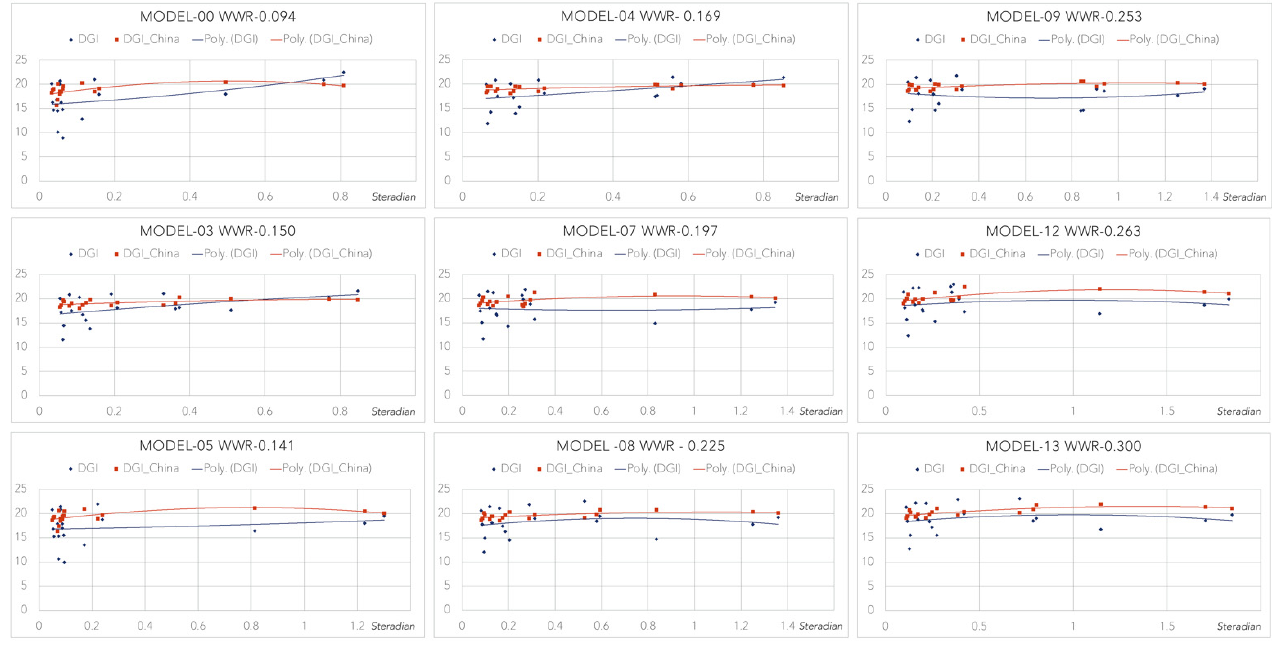
Figure 10. Comparative study on camera viewing location in the back of the room with solid angles ( X -axis) against DGI and DGI China evaluation ( Y -axis).